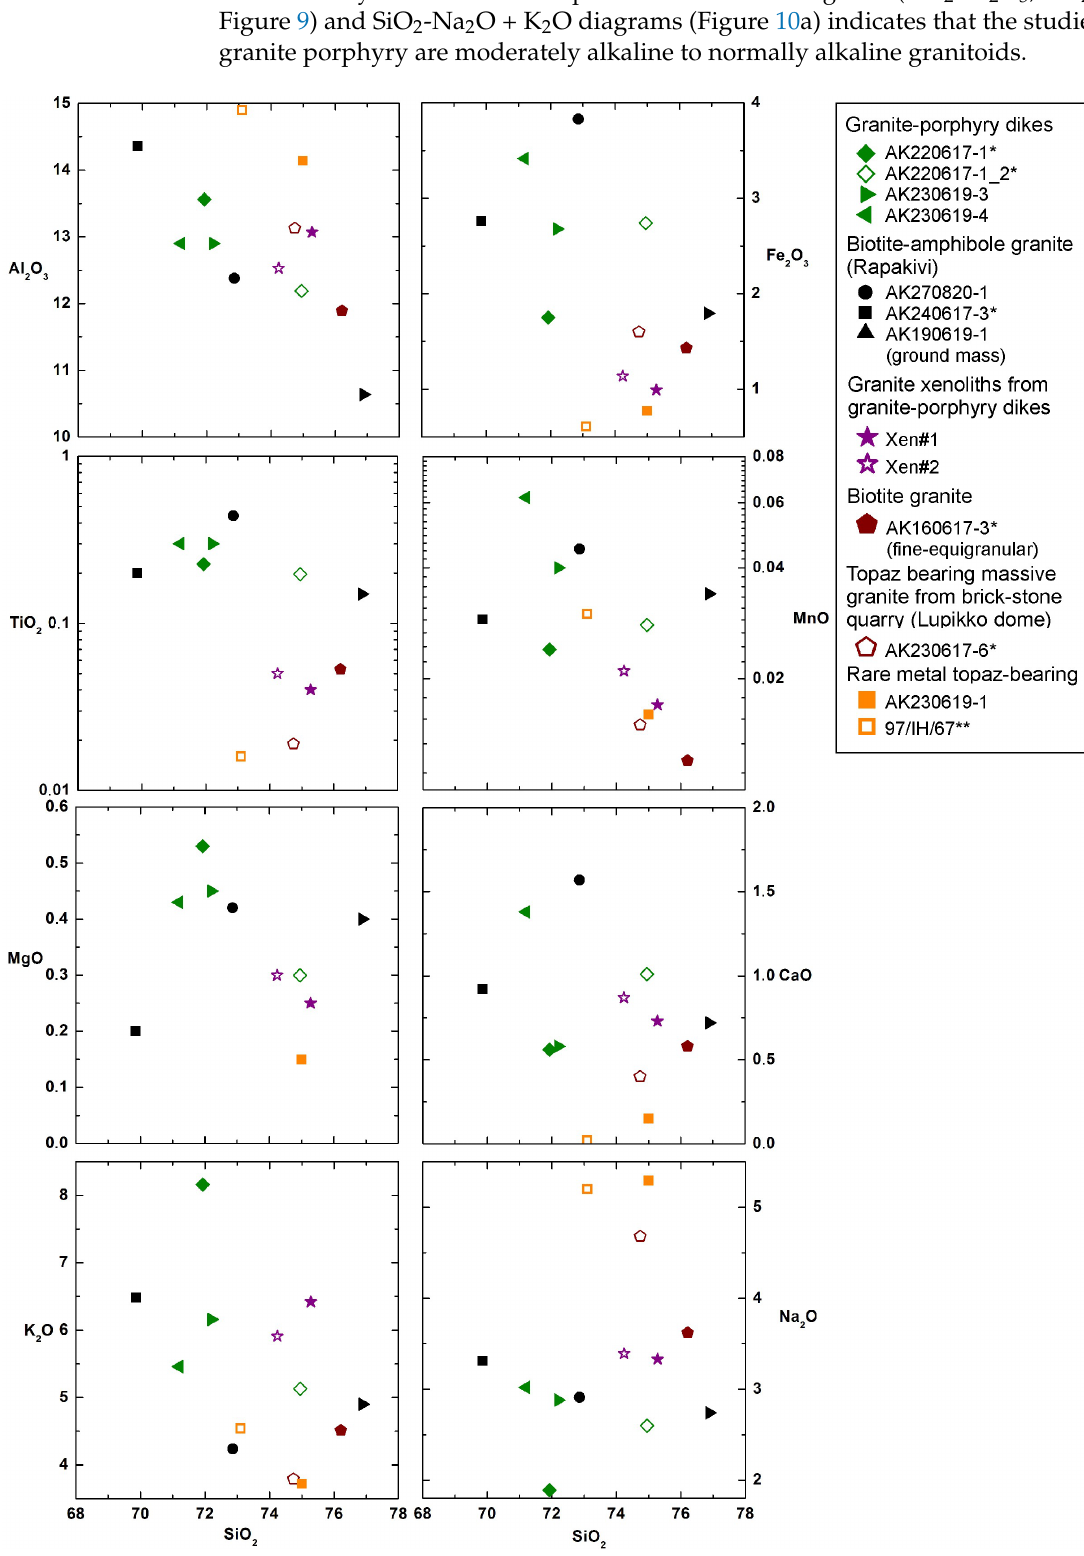
Figure 9. Harker diagrams for the major elements (in wt%). * Rocks from the Salmi batholith (data taken from [32]), ** Eurajoki stock, related to the Laitila batolith (ARG) (taken from